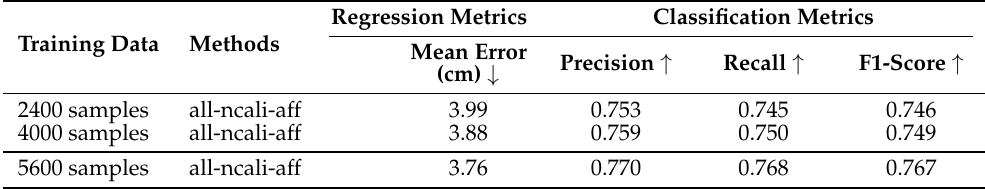
Figure 10. The error of the models trained by a different number of samples. The vertical axis unit is cm. Table 2. Comparison between the models trained by a different number of